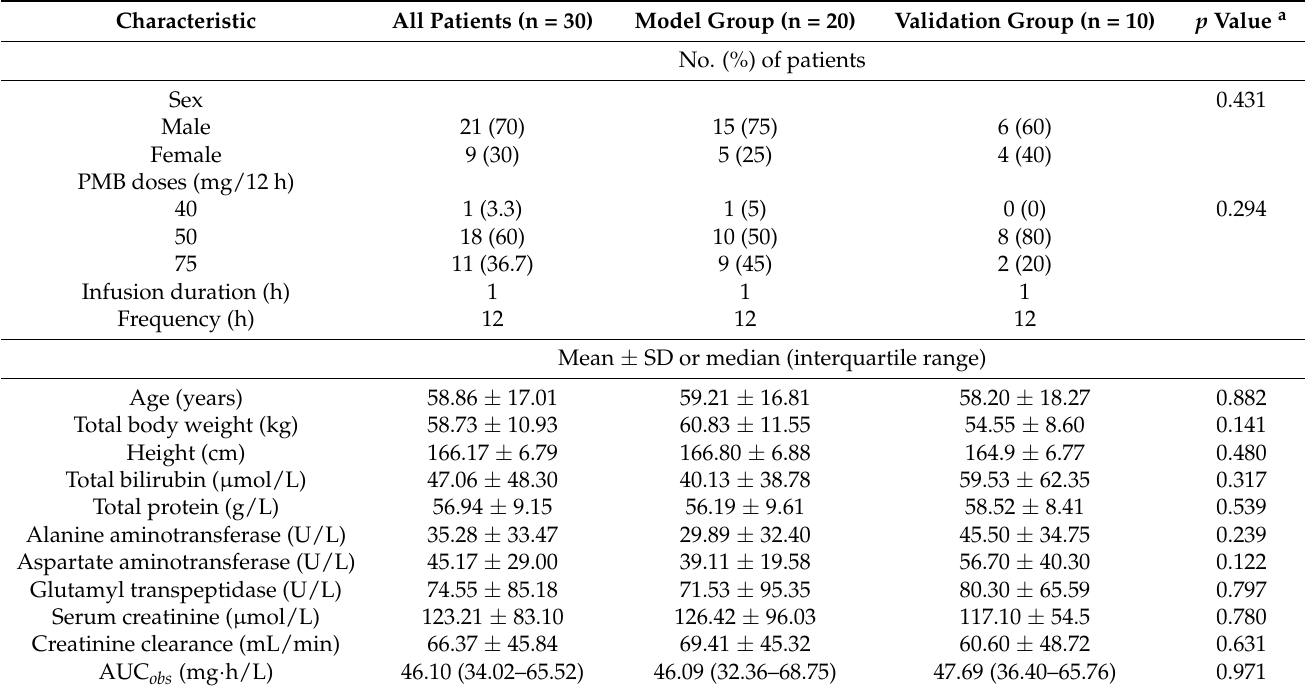
Table 1. Characteristics of patients included in our